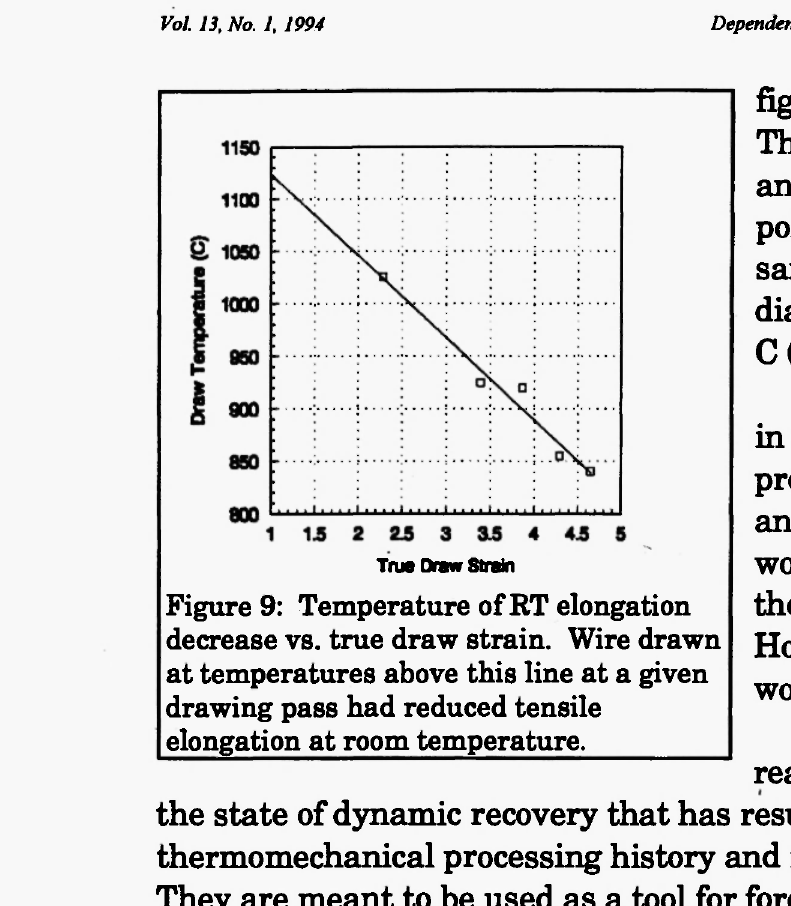
Figure 9: Temperature of RT elongation decrease vs. true draw strain. Wire drawn at temperatures above this line at a given drawing pass had reduced tensile elongation at room